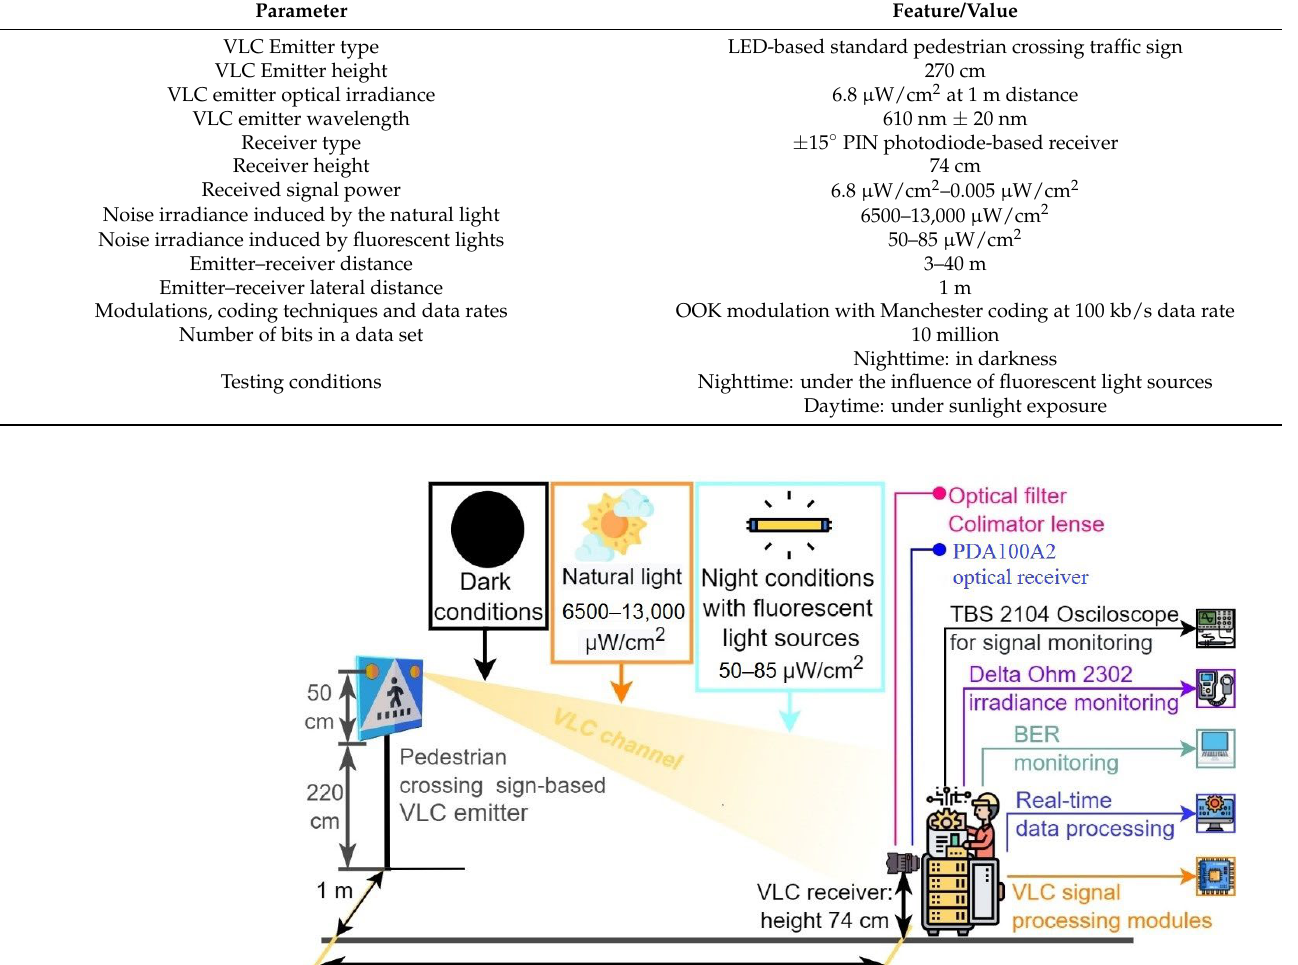
Table 6. Summary of the experimental parameters.